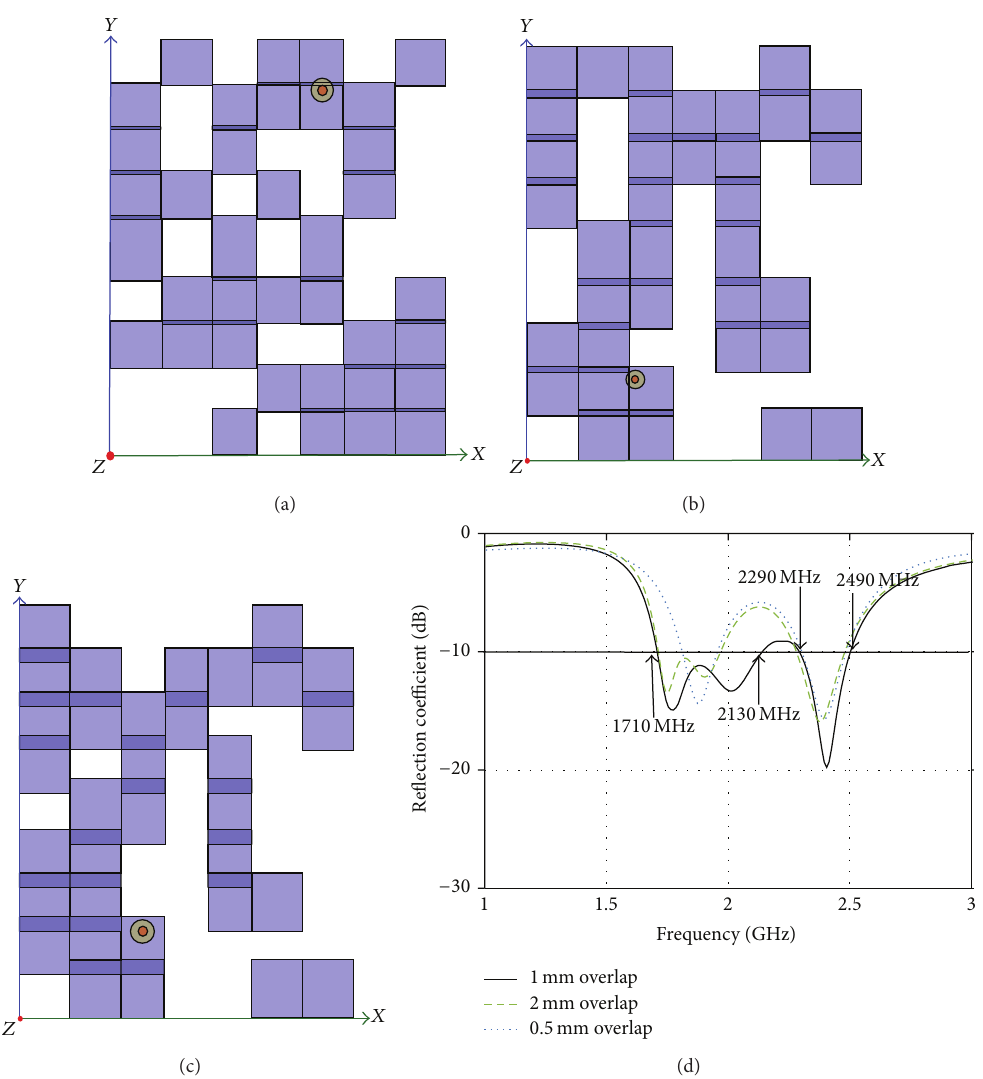
Figure 4: The optimized MPAs with uniform overlaps. (a) Optimized design for overlap of 0.5 mm. (b) Optimized design for overlap of 1mm. (c) Optimized design for overlap of 2mm. (d) Reflection coefficient.